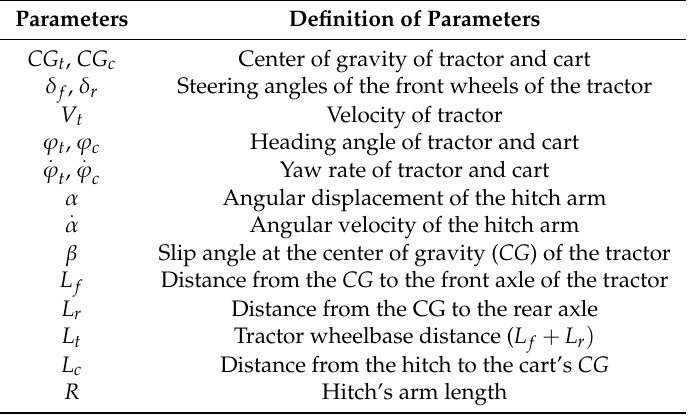
Figure 1. Schematic representation of tractor-cart system. Table 1. Tractor and cart kinematic bicycle model parameters definition.